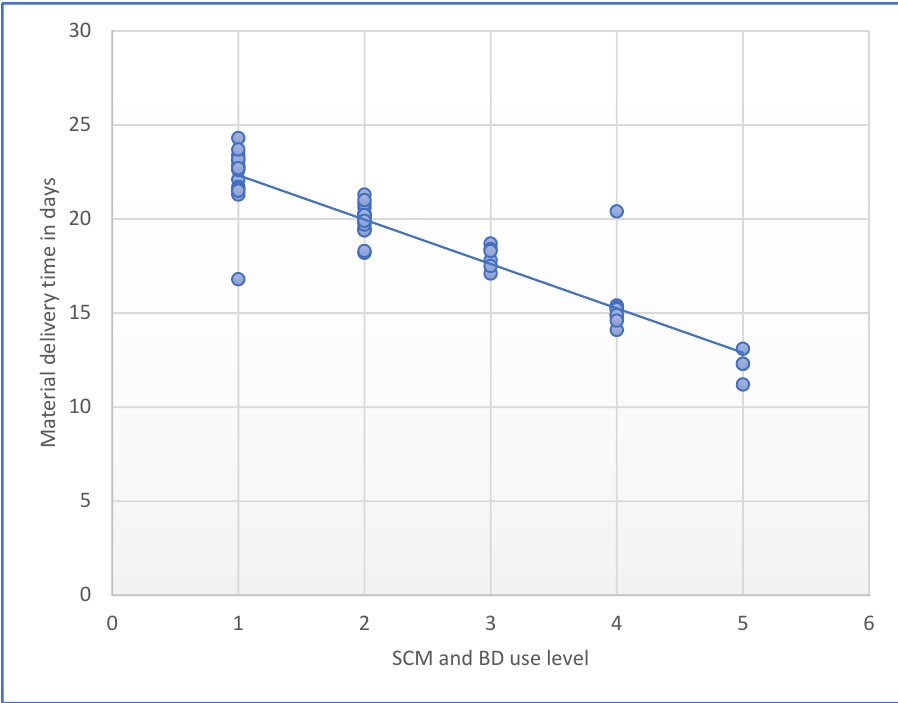
Figure 2. Relationship between SCM and BD use level and material delivery time in days. Appl. Sci. 2021 , 11 , x FOR PEER REVIEW